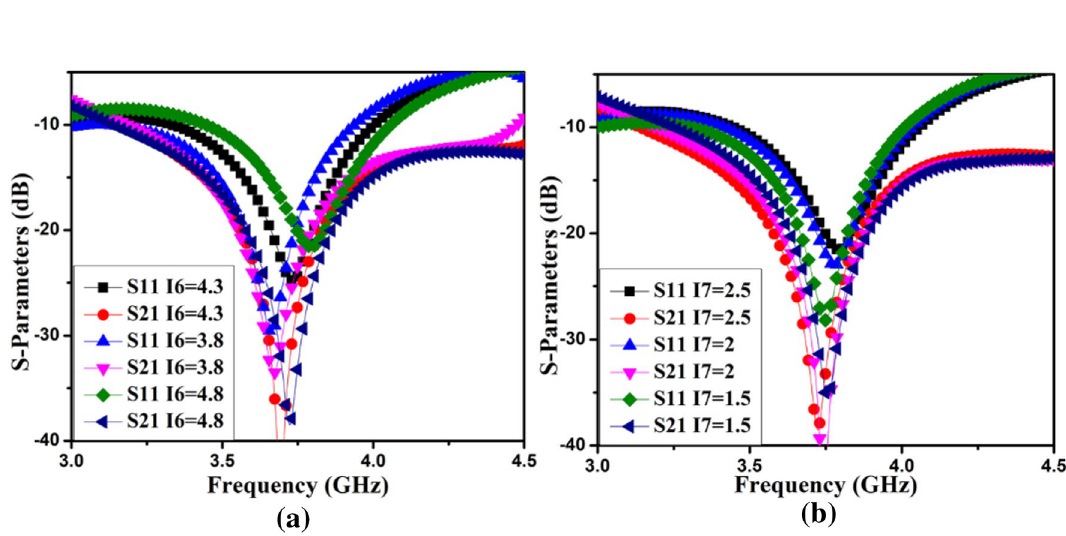
Figure 8. The S-parameter of the AntII operates with ( a ) I6, ( b )